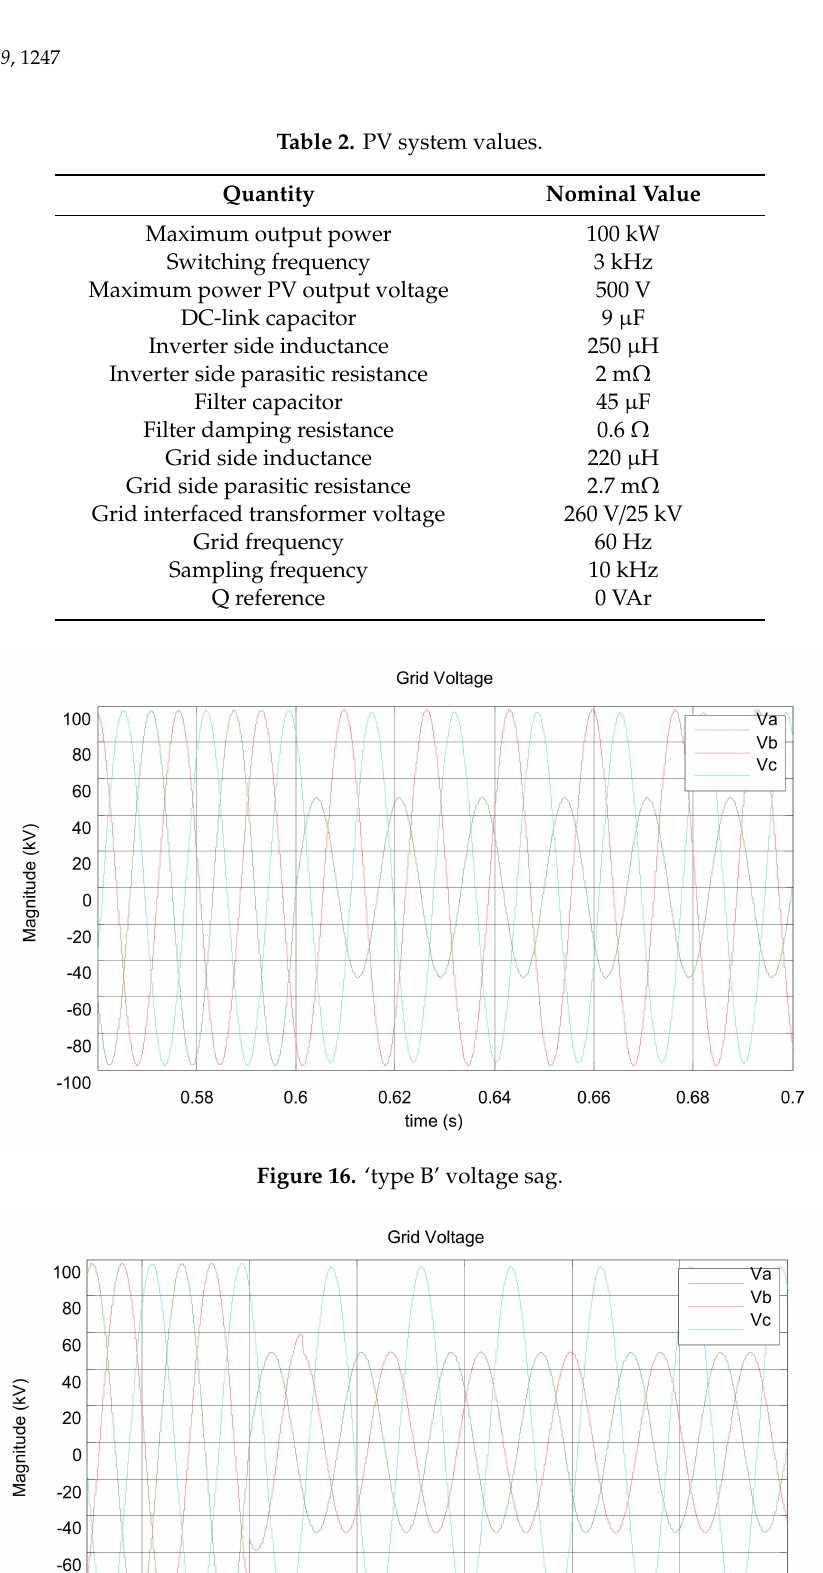
Figure 17. ‘type C’ voltage